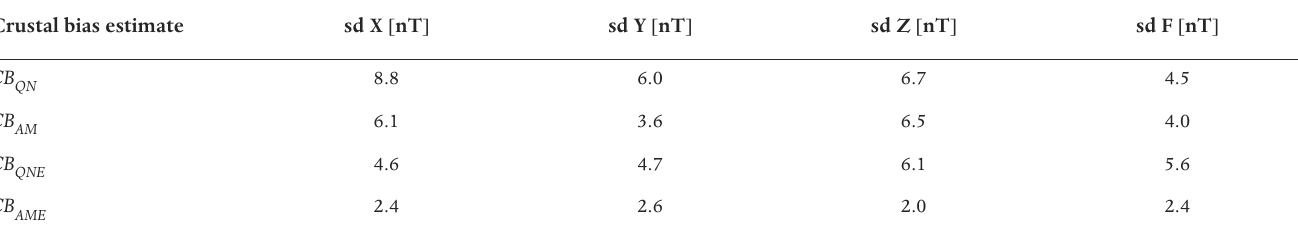
Table 2. Average standard deviations of the crustal bias